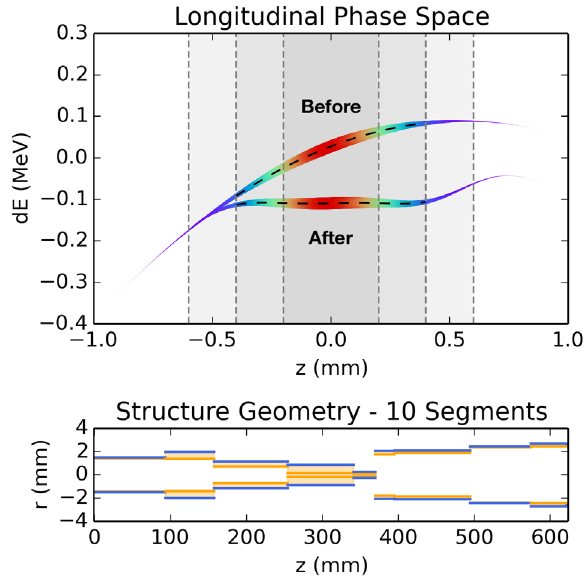
FIG. 9. LPSS optimization results based on the ARES working point WP1 shown in Table II. The optimization goal was to completely remove any correlated energy spread within a 4 σ ROI. The color and thickness visualize the current profile. The gray shaded areas correspond to the 2, 4 and 6 σ regions respectively. The head of the bunch is on the left (negative z values). Below the main plot, the geometry of the final segmented DLW is visualized, with the orange line corresponding to the inner radius and the blue line to the outer radius.